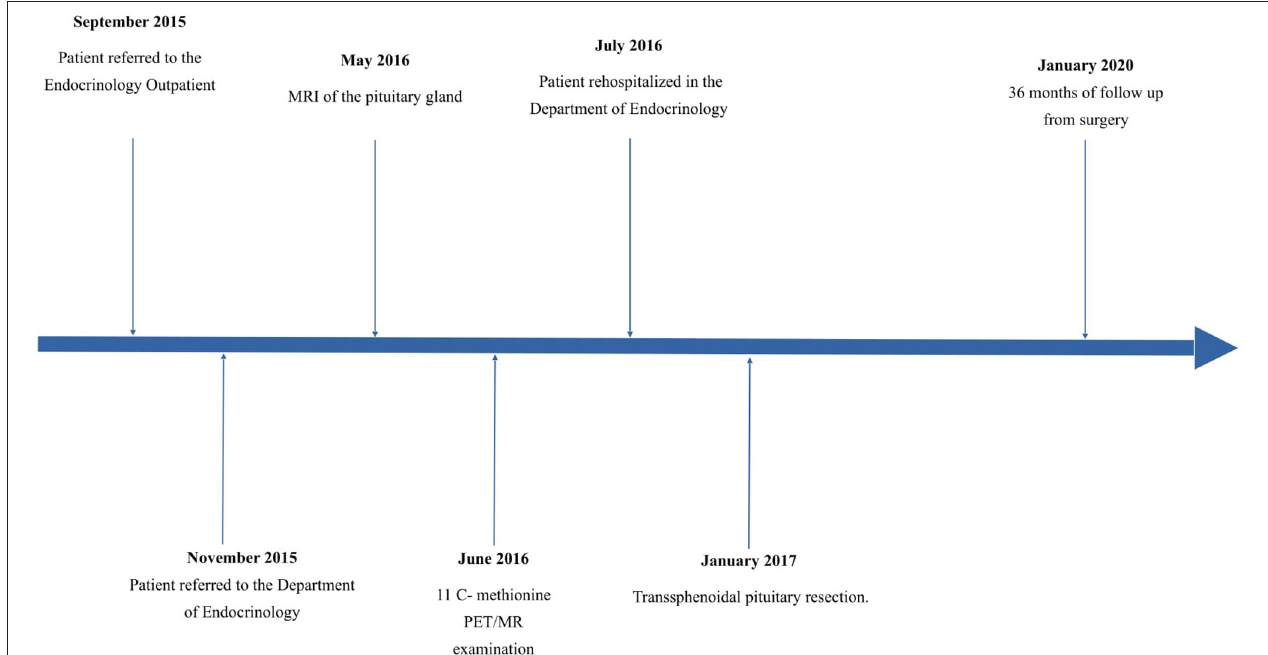
FIGURE 5 | Timeline with information from the episode of